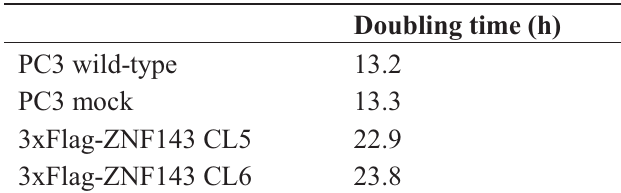
Table 1. Doubling time of wild-type PC3 cells, PC3 cells with forced expression of 3xFlag-ZNF143 and mock transfected cells.